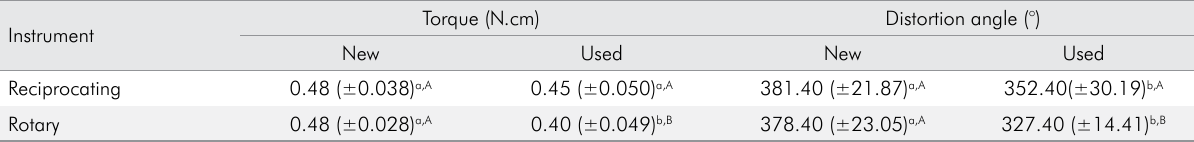
Table 3. Mean and standard deviation of torsional strength (N.cm) and distortion angle (°) of the instruments subjected to the torsional test after glide path preparation using different kinematics